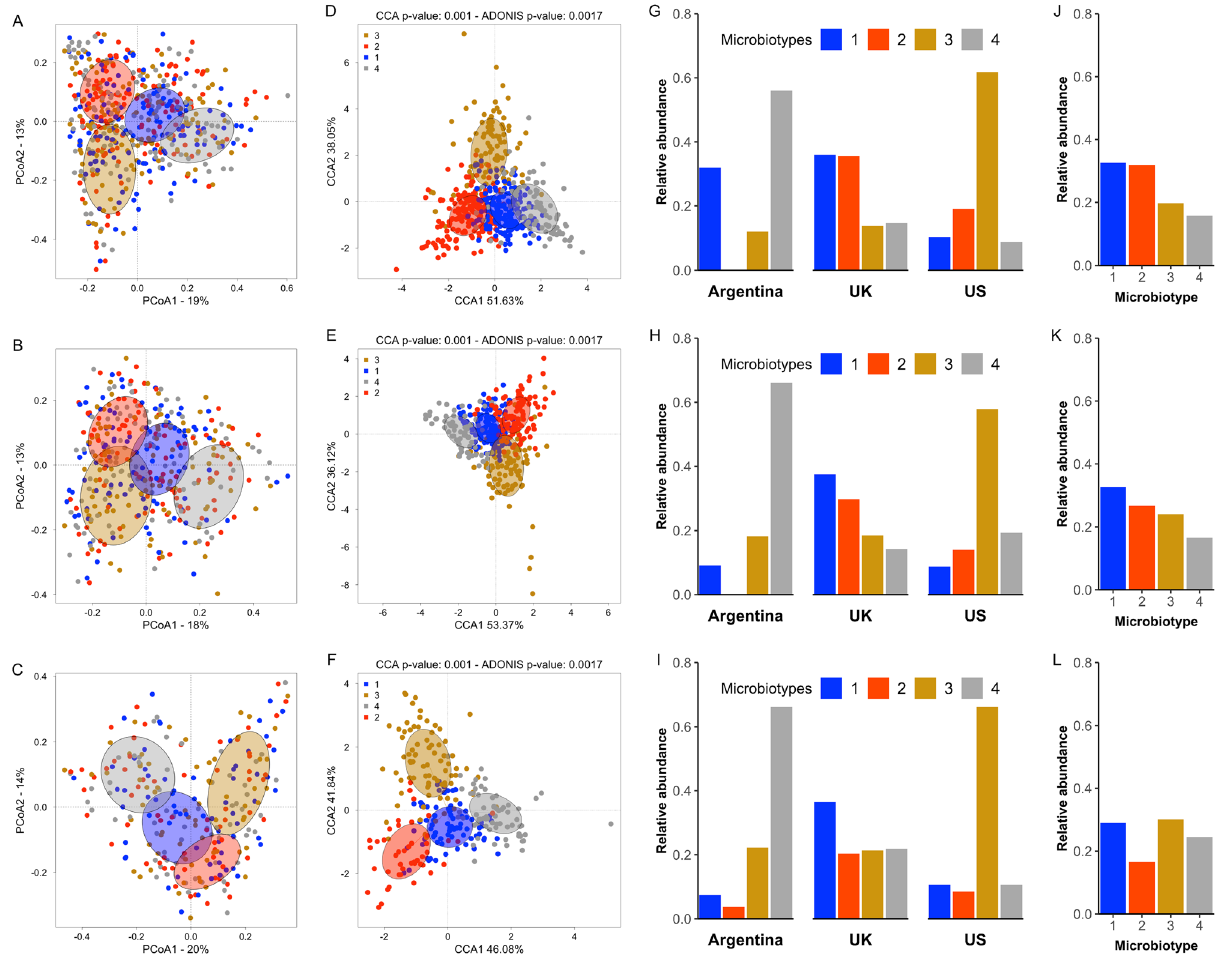
Figure 3. Analysis of microbiotypes distribution in the different subject population according their BMI status. ( A – F ) Clustering of the microbiotypes according to the distinct population in Lean ( A , D ), Overweight ( B , E ) and Obese ( C , F ) groups using the Principal Coordinates Analysis (PCoA) ( A – C ) and the Canonical Correspondence Analysis method (CCA) ( D – F ) based on the Bray–Curtis distance. ( G – I ) Distribution of Microbiotypes inside the distinct populations in Lean ( G ), Overweight ( H ) and Obese ( I ) groups. ( J – L ) Total distribution of Microbiotypes in Lean ( J ), Overweight ( K ) and Obese ( L ) groups. Each color represents a Microbiotype (i.e. Microbiotype-1, -2, -3 and